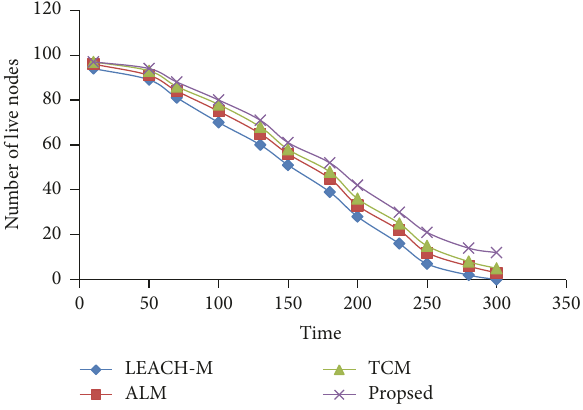
Figure 4: Alive number of nodes versus